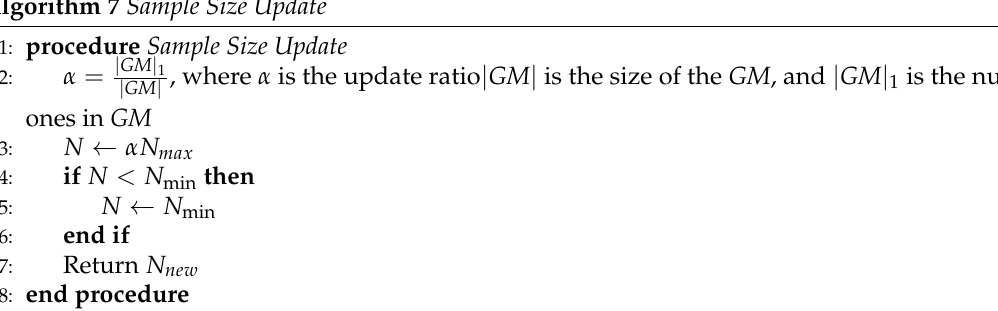
Algorithm 7 Sample Size